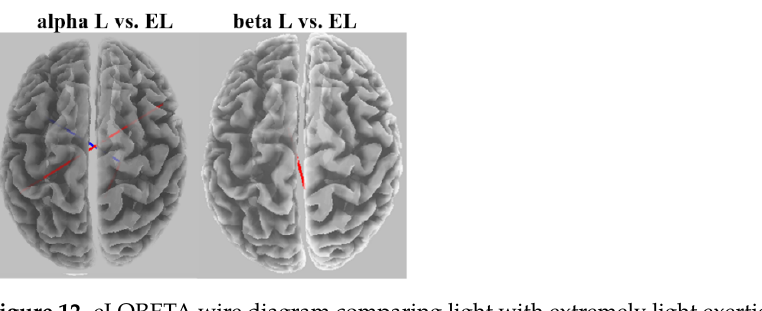
Figure 12. eLORETA wire diagram comparing light with extremely light exertion for each frequency band. EL: extremely light and L: light.